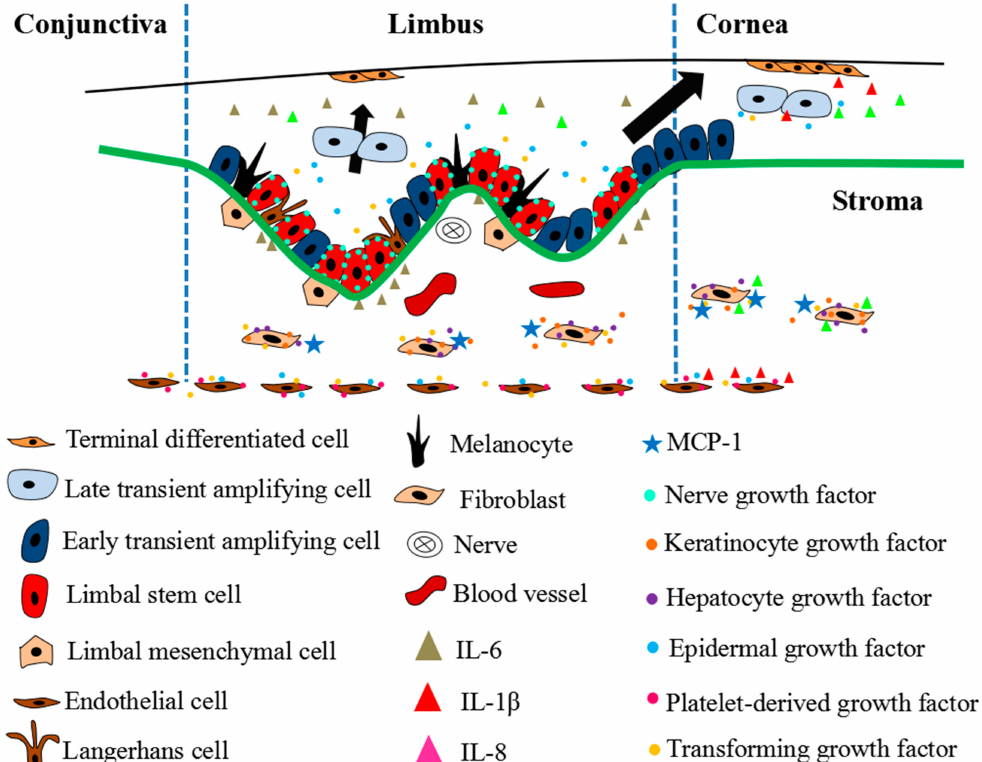
Figure 1. Schematic of the LSC niche. The LSC niche located at Vogt in limbal epithelium. There are several types of cells including limbal stem cells, early transient amplifying cells, melanocytes and langerhans cell within the niche. The limbal stroma, which is highly innervated and vascularized, is located underneath the basement membrane (BM). In limbal stroma, the mesenchymal cells can be found in the limbal stroma and play an important role in the LSC niche. Cyotokines play a role of mediator for cell–cell communication within the